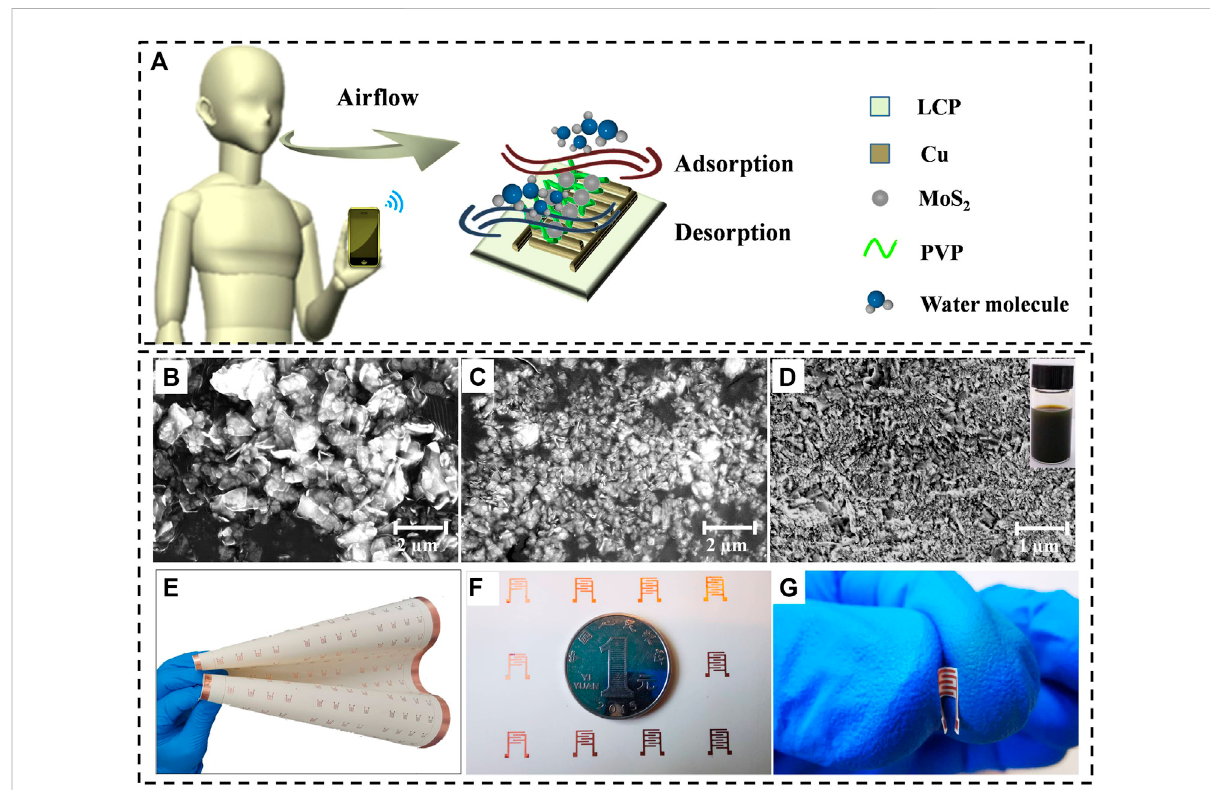
FIGURE 1 (A) Schematic illustration of humidity sensor fabricated and respiratory rate monitoring. SEM images of bulk MoS 2 without (B) and with (C) liquid-phase ultrasonic exfoliation, (D) PVP-assisted liquid-phase ultrasonic exfoliation of MoS 2 (the upper right corner is the photograph of MoS 2